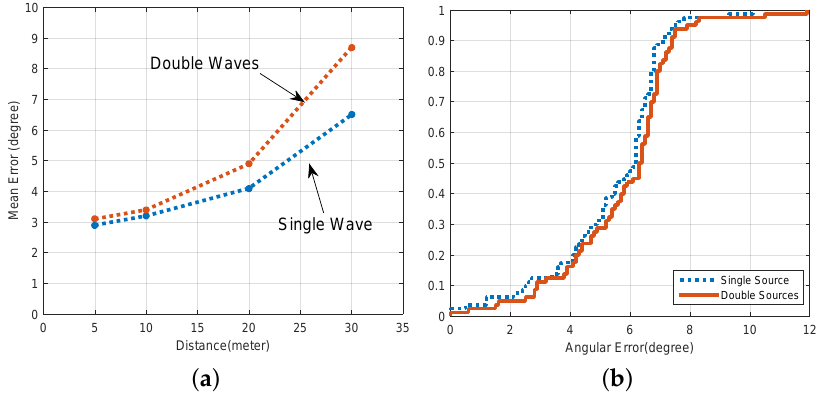
Figure 12. ( a ) the same acoustic source with single and multiple waves; and ( b ) the CDF of the angular error in a noisy